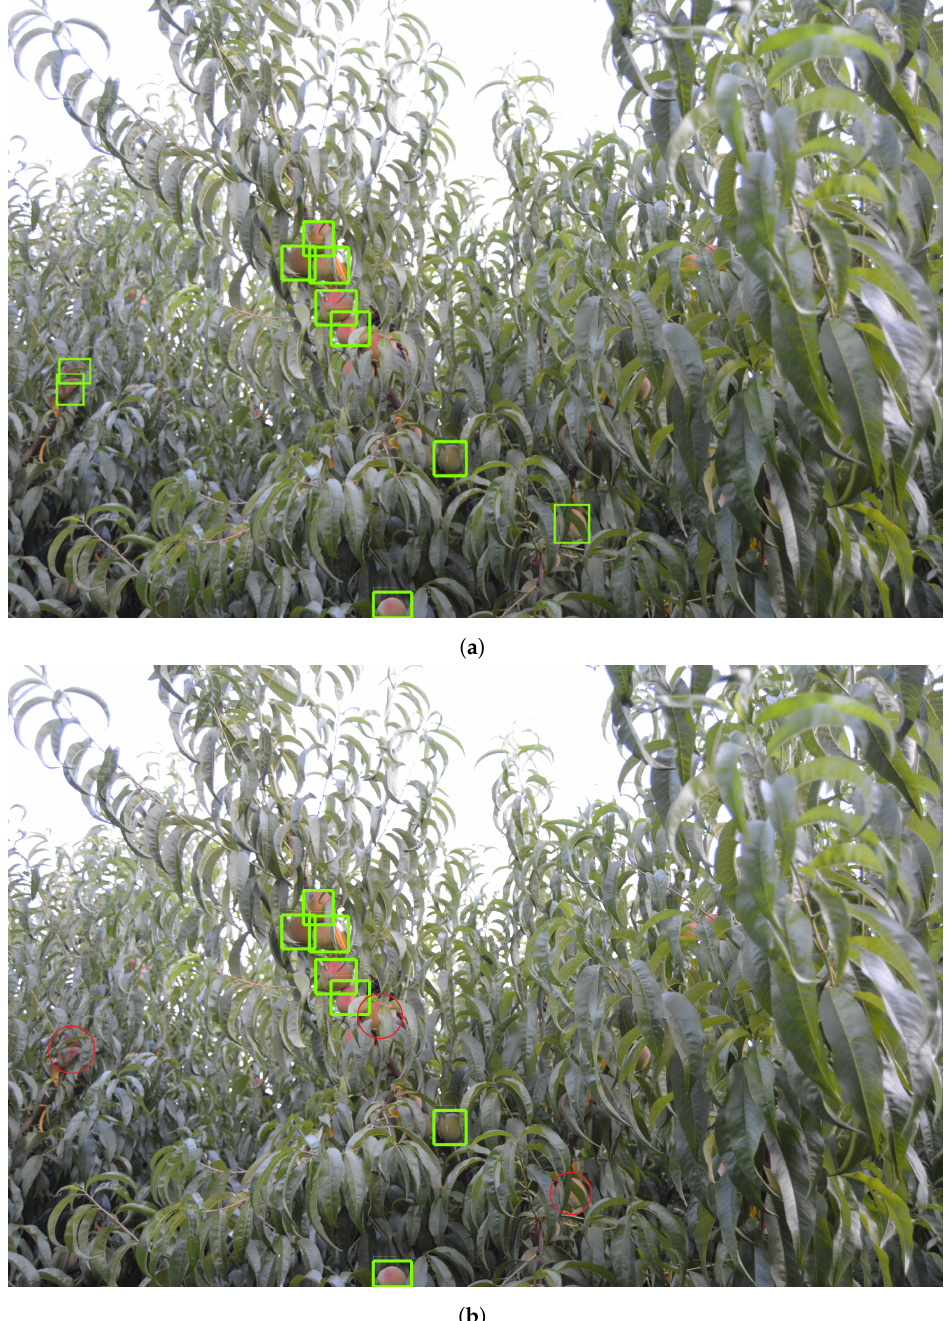
Figure 10. Test result in a different orchard (sample-1): ( a ) shows a test image and its manually annotated fruits; ( b ) shows the predicted fruits detection by the model. The green rectangular boxes are corrected detections, and the red circles are illustrative missing